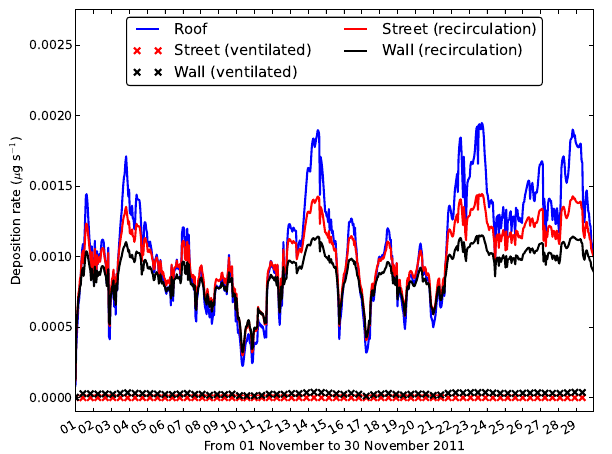
Figure 14. Evolution of dry deposition velocity as a function of wind speed and building